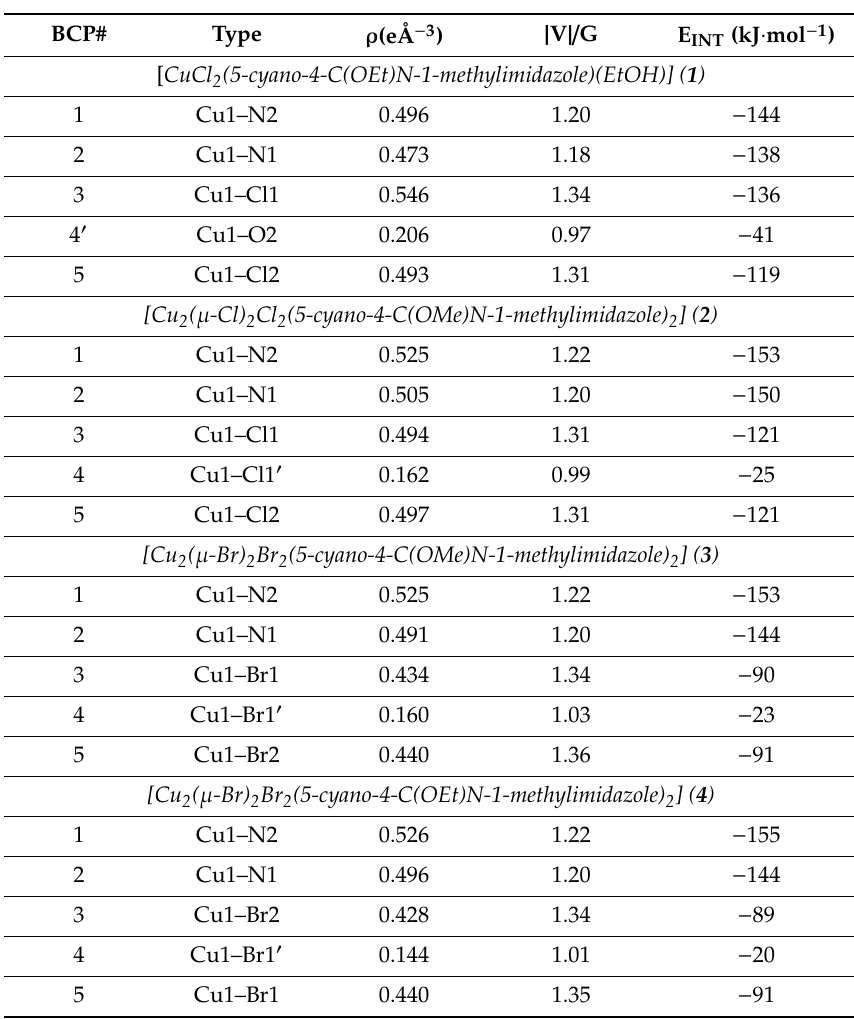
Table 2. Properties of the electron density in the selected bond critical points (BCPs) for compounds 1 – 4 . For the numbering scheme of the BCPs, see Figure 3. Atom numbers follow the scheme in Figure